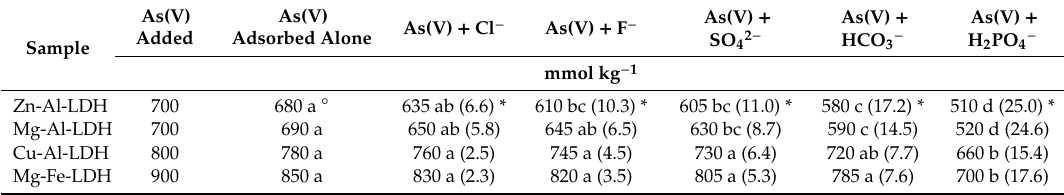
Table 2. Arsenate adsorption (mmol kg − 1 ) in the presence of competing inorganic anions on the four LDHs, after 24 h of reaction at pH = 7 and 20 ◦ C. Initial anion / As(V) ratio equals to 1, with 50% of surface coverage.